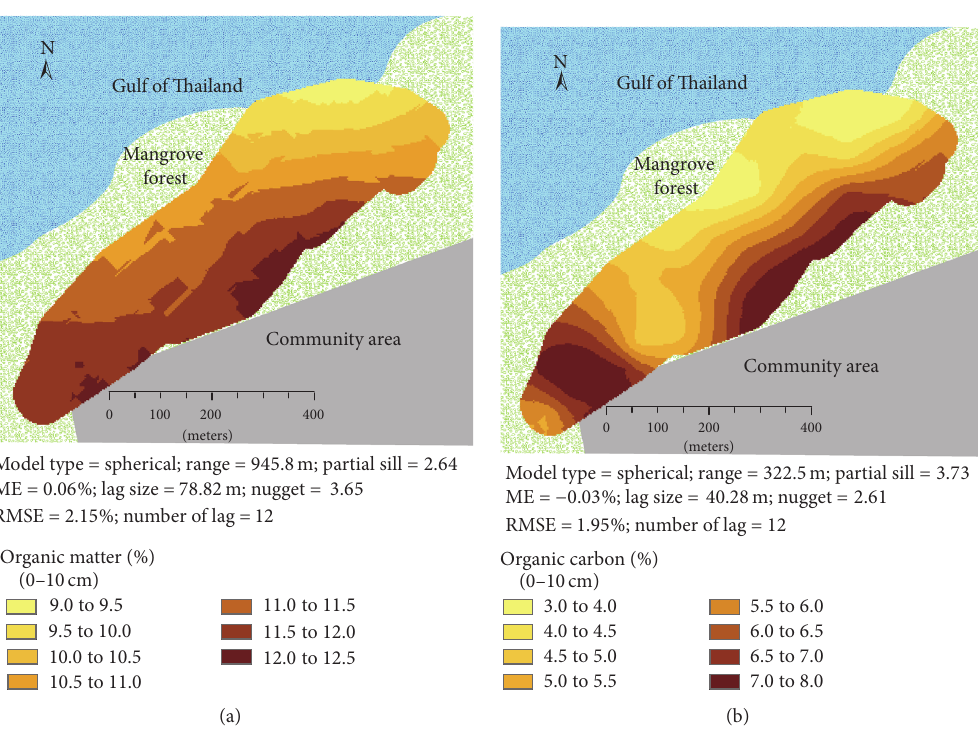
Figure 2: Estimated predictions of (a) soil organic matter content (%) and (b) soil organic carbon (%) content based on an ordinary kriging using 29 soil samples. ME is mean error and RMSE is root mean square